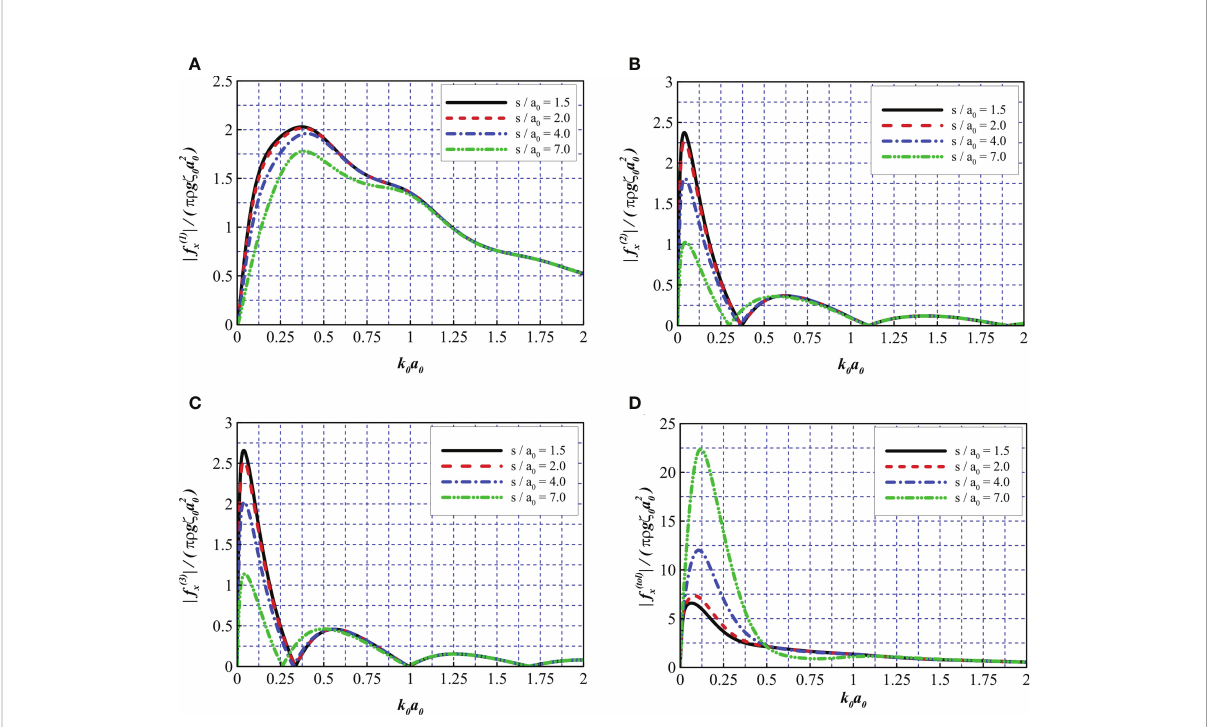
FIGURE 15 Comparison of wave force for different thicknesses of the friction wheel. (A) j f (1) x j = ( pr g z 0 a 2 0 ), (B) j f (2) x j = ( pr g z 0 a 2 0 ), (C) j f (3) x j = ( pr g z 0 a 2 0 ), and (D) j f (tol) x j = ( pr g z 0 a 2 0